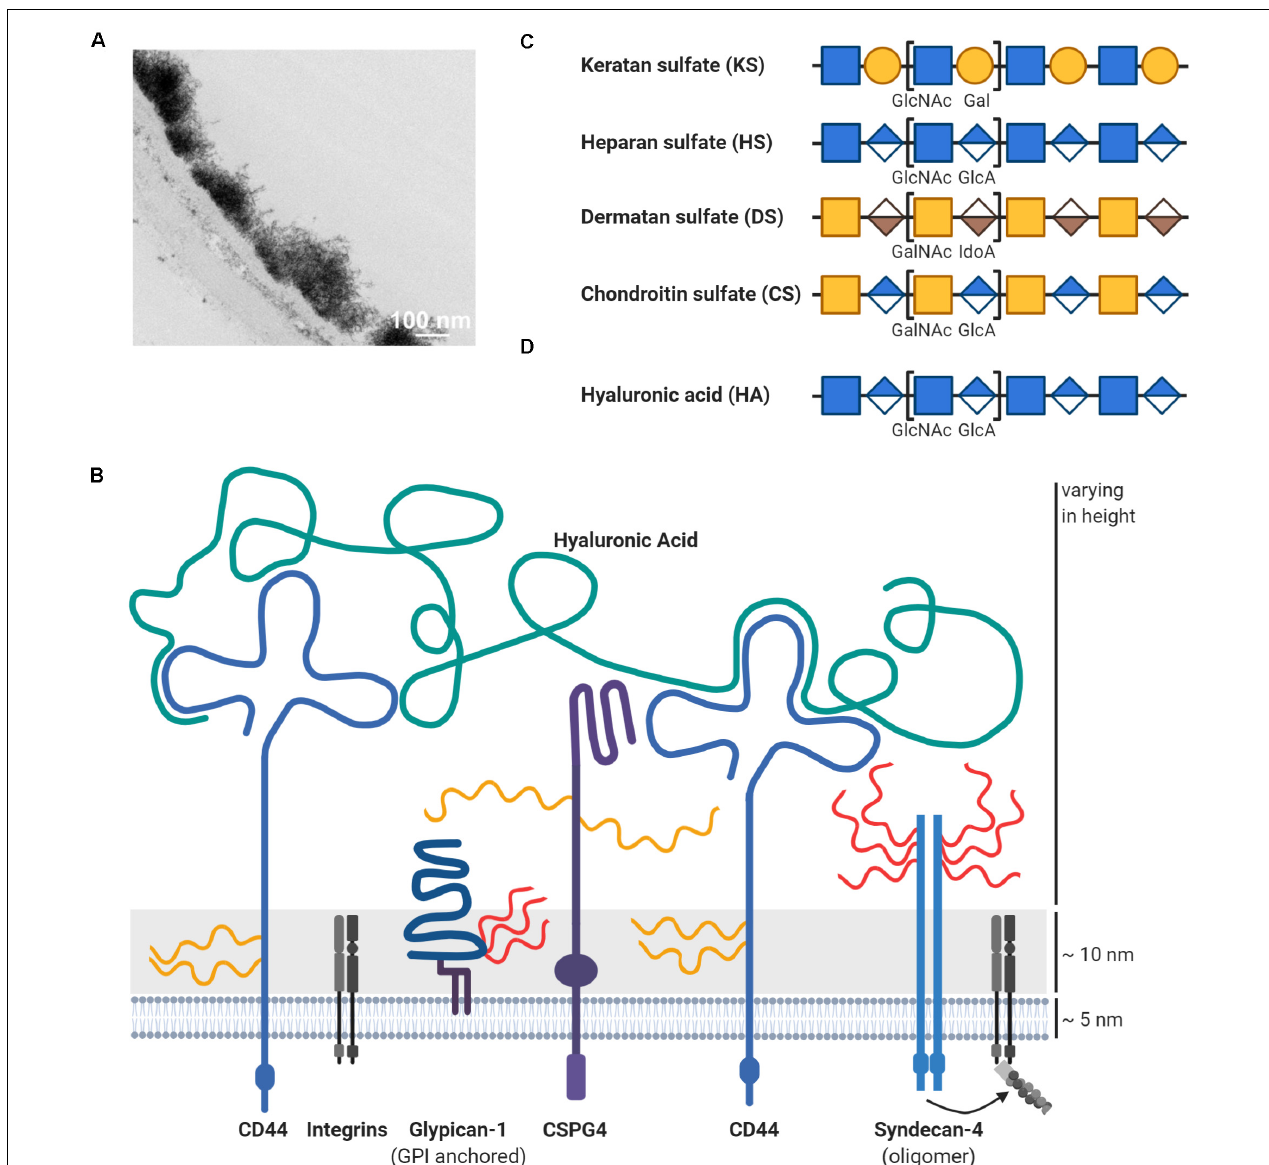
FIGURE 2 | Schematic overview of proteoglycans in the glycocalyx. (A) The glycocalyx is a dense network of carbohydrates on the cell surface, here exemplified on top of the endothelium. This transmission electron microscopic image with lanthanum nitrate staining was reused from Okada et al. (2017) under CC BY 4.0 license. (B) The thick carbohydrate layer on the cell surface extends beyond the length of membrane proteins like integrins. One important glycocalyx component are proteoglycans, which consist of a protein core (blue) and covalently attached glycosaminoglycans such as heparan sulfate (HS; in red) or chondroitin sulfate (CS; in yellow). Depicted are some proteoglycans, which are mentioned and discussed throughout the review like chondroitin sulfate proteoglycan 4 (CSPG4). Hyaluronic acid (HA; in green) is another important glycosaminoglycan component in the glycocalyx, but is distinct through the lack of a protein core. Hyaluronic acid is attached to the cell surface via interactions with its receptors like CD44, which is itself a proteoglycan. Other glycocalyx components like glycoproteins are not shown due to abstractification. Depiction of the disaccharides units for (C) glycosaminoglycans attached to proteoglycans (keratan sulfate/KS, heparan sulfate/HS, dermatan sulfate/DS, and chondroitin sulfate/CS) and (D) of hyaluronic acid (HA), which is non-covalently attached to its receptors. Glycosaminoglycans can be subjected to further modifications, such as sulfation or epimerization, which is not shown for simplicity. Please refer to the main text for details and